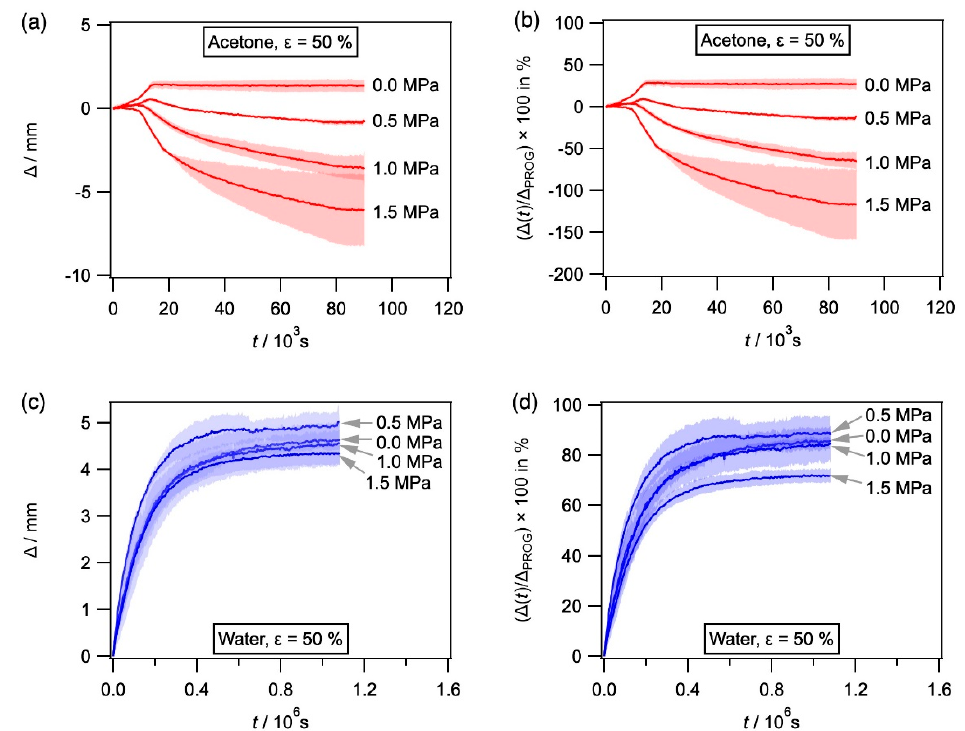
Figure 10. Evolution of Δ with time for SMP-E specimens programmed to 50% and exposed to acetone and water (unconstrained and with varying end loads). ( a , b ) Exposure to acetone. ( c , d ) Exposure to water. ( a , c ) Δ in mm plotted as a function of time in s. ( b , d ) ( Δ ( t )/ Δ PROG ) × 100 in % vs. time in s.